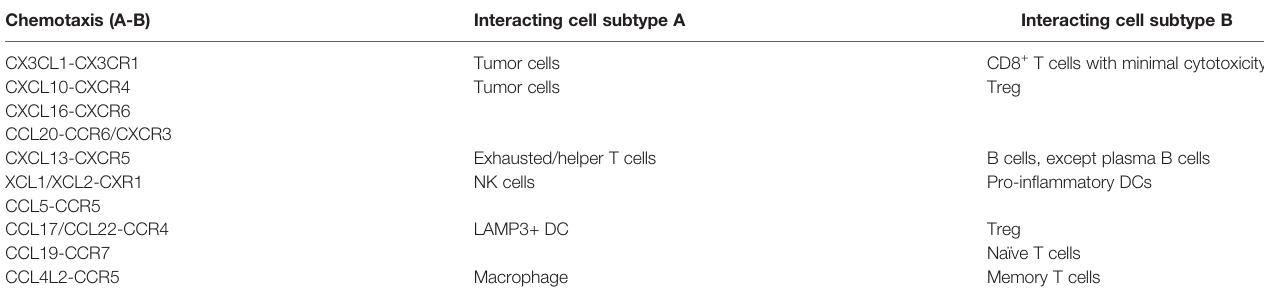
TABLE 1 | Novel chemotaxis responsible for cell recruitment in the NPC microenvironment. Chemotaxis (A-B)